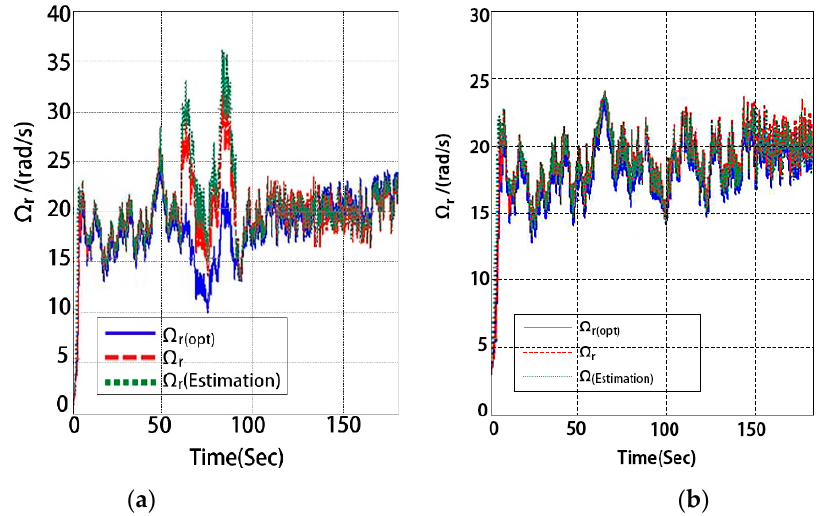
Figure 5. The trajectories of strategy. Figure 5. The trajectories of Ω r . ( a ) Without using the FRSFTC strategy; ( b ) Using the FRSFTC strategy. Figure 5. The trajectories of strategy.